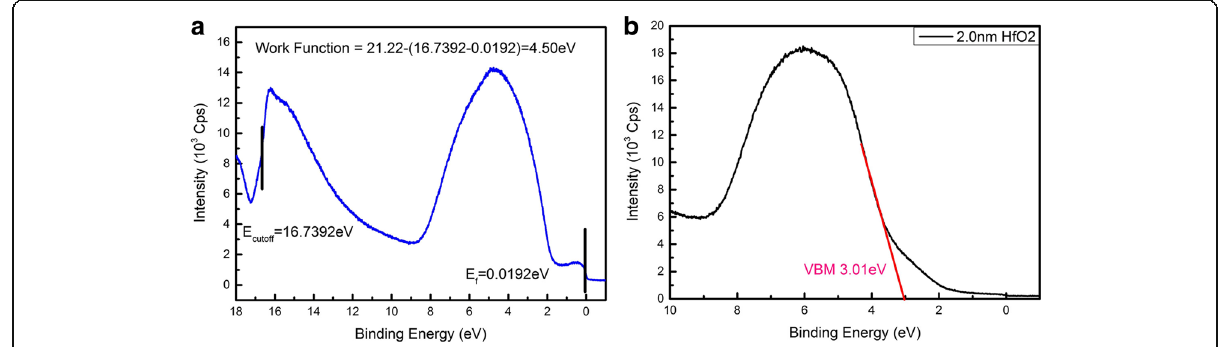
Fig. 3 UPS measurement. a UPS of TiN. b UPS of 2-nm HfO 2 on TiN